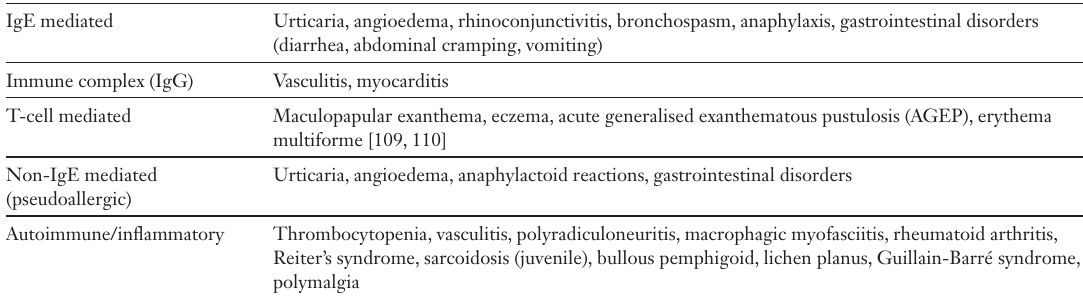
Synopsis of potential immune-mediated reactions to vaccines.